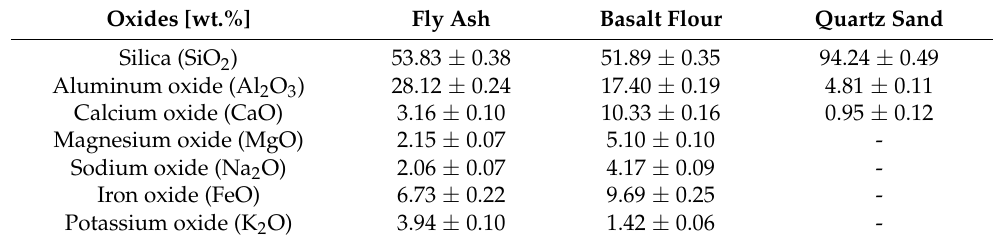
Table 1. Oxide composition of raw materials.